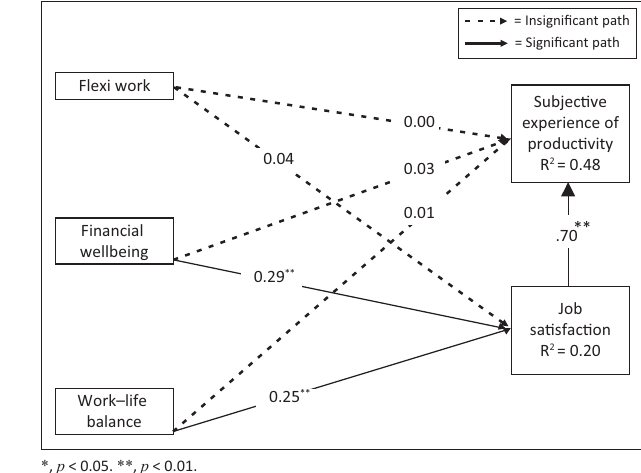
FIGURE 2: The results of structural equation modelling analysis for the hypothesised model: Model 1. TABLE 4: Direct, indirect and total standardised effects of flexible work, financial well-being, work–life balance and productivity (and job satisfaction in the alternative model). Dependent variables